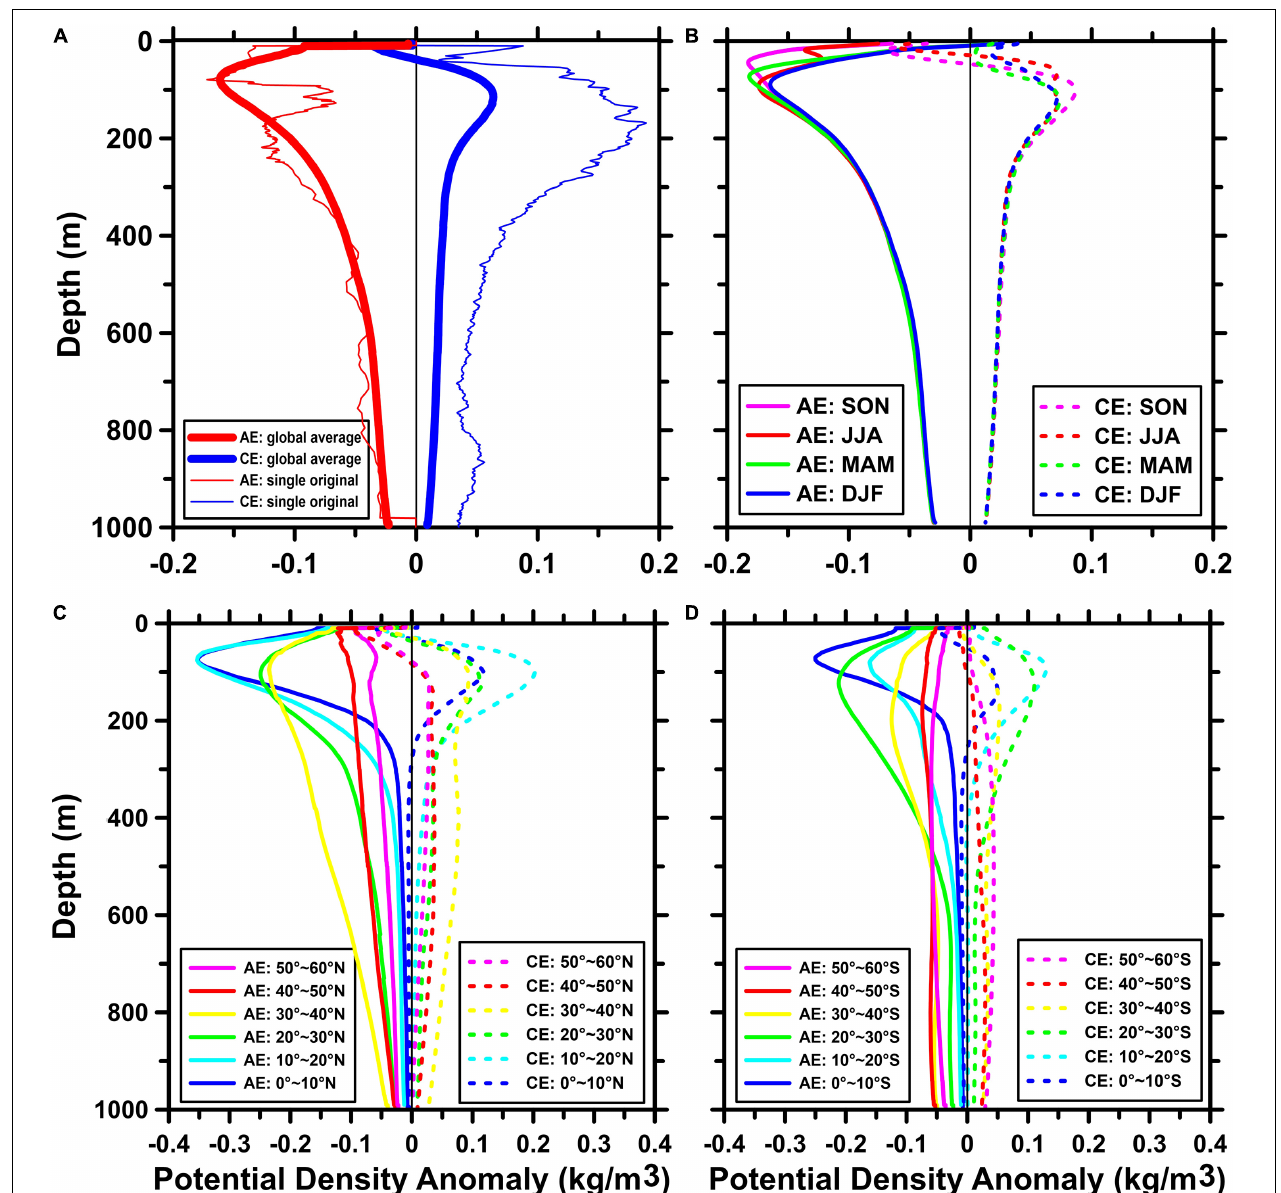
FIGURE 3 | Vertical profiles of the potential density anomaly of Alt eddy. (A) Global average profiles from 2002 to 2019 (thick lines). The thin red (blue) line is the original eddy profile inside Alt anticyclonic eddies (AE) [cyclonic eddies (CE)], and the buoy number is 1901621 on March 26, 2018 and 1901817 on October 9, 2018, respectively. (B) Global average profiles in different seasons. (C) Latitudinal average profiles in the Northern hemisphere and (D) latitudinal average profiles in the Southern